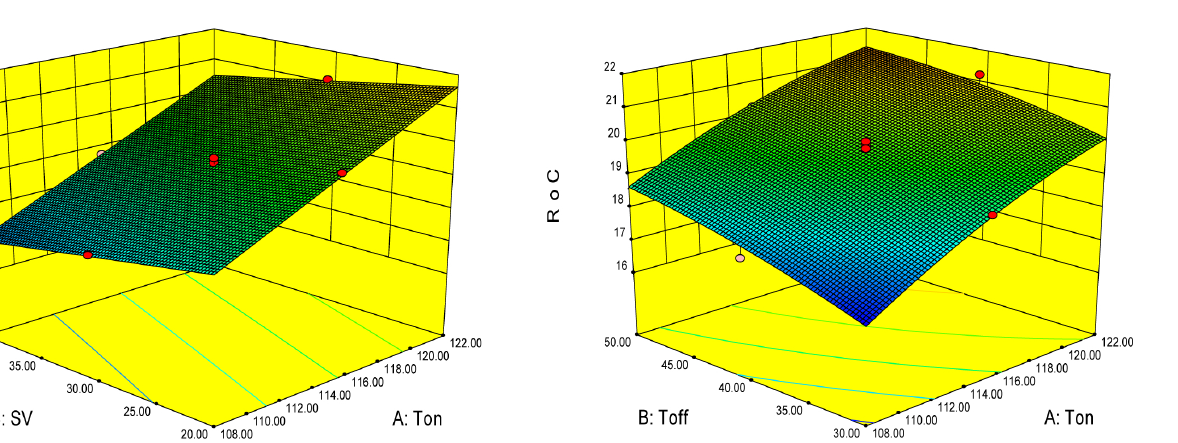
Figure 7b. Combined e ff ects of T on and SV on SR.